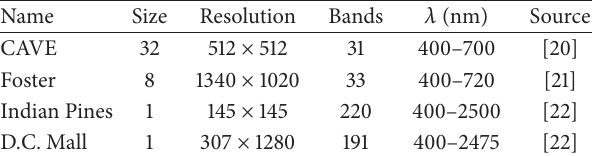
Table 2: Average drawing times and